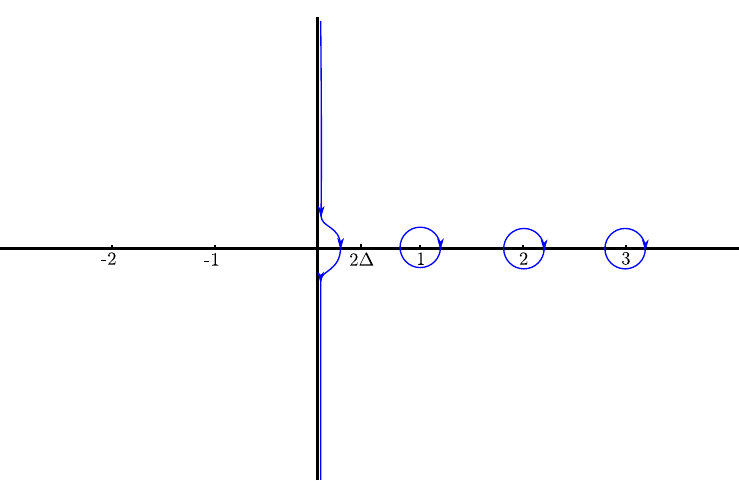
Figure 5 . The integration contour for the